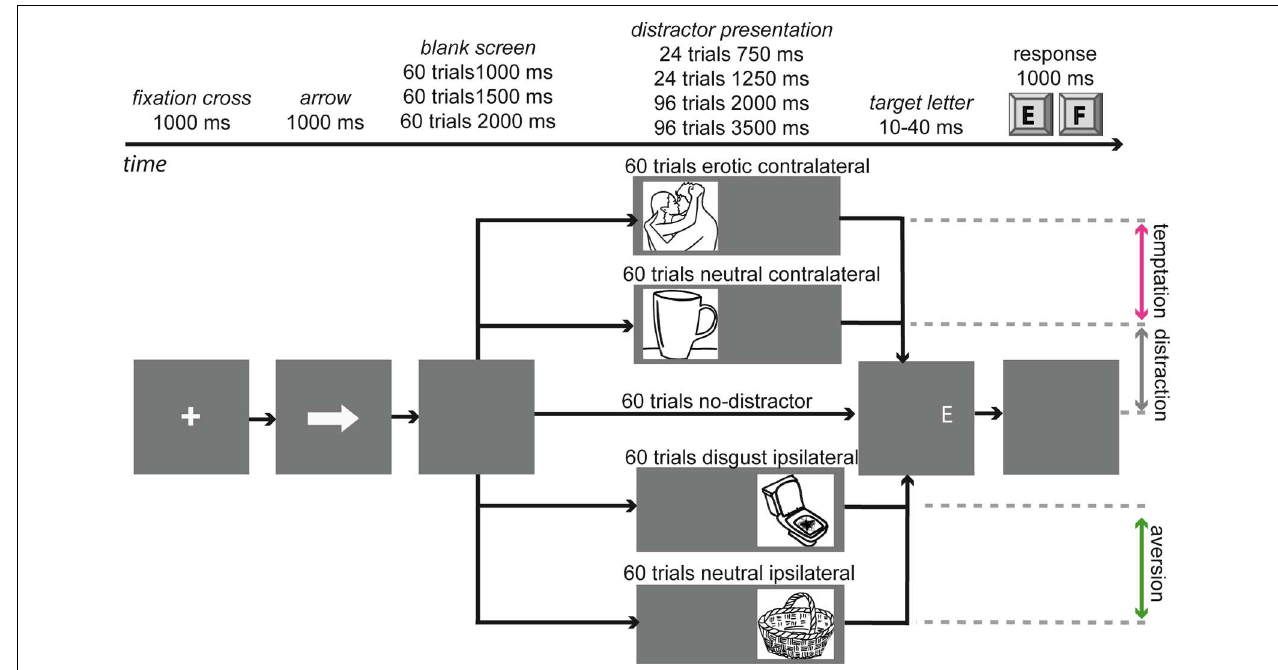
FIGURE 1 | Display of the trial Schema. Each trial starts with a fixation cross followed by an arrow indicating the location of the next target letter 5.9 ◦ of visual angle left or right from the center. After the arrow presentation the screen was empty for a variable delay. Drawings are placeholders for photographs from